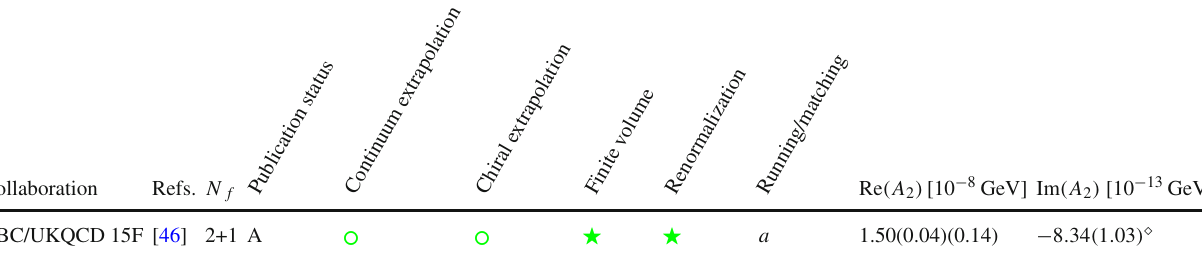
Table 29 Results for the real and the imaginary parts of the K → ππ decay amplitude A 2 from lattice-QCD computations with N f = 2 + 1 dynamical flavours. Information about the renormalization and matching to the MS scheme is indicated in the column “running/matching”, with details given at the bottom of the table